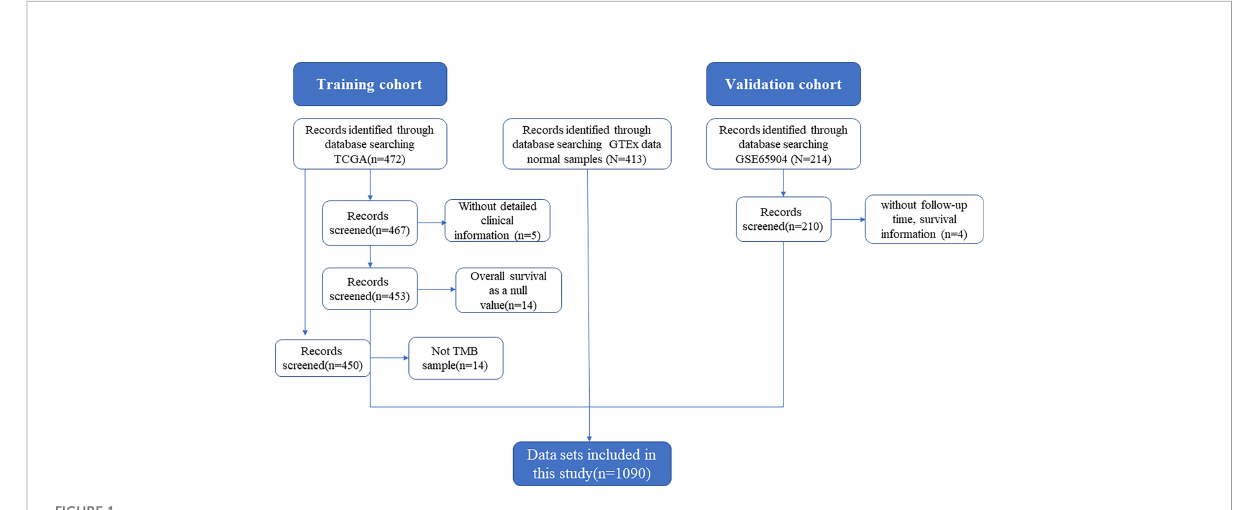
FIGURE 1 Flow-diagram of the datasets selection